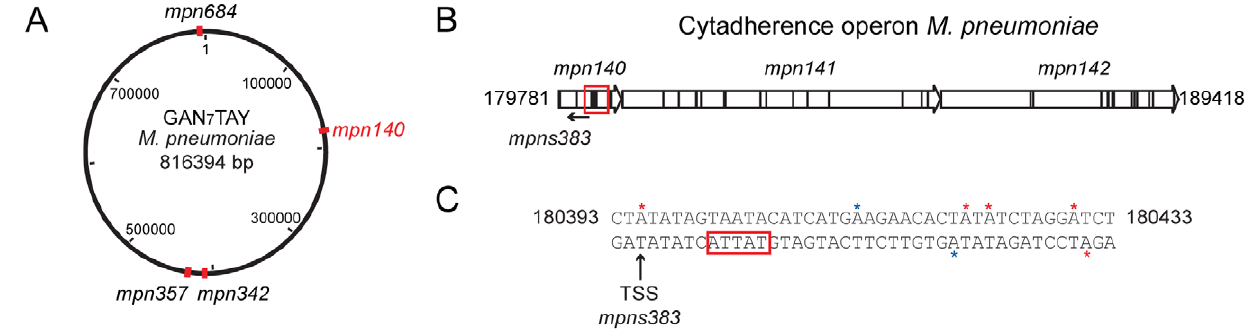
Figure 3. Genome-wide distribution of 5 9 -G A N 7 TAY-3 9 /3 9 -CTN 7 A TR-5 9 motif. ( A ) Map of the genome of M. pneumoniae representing the enriched regions for the 5 9 -G A N 7 TAY-3 9 /3 9 -CTN 7 A TR-5 9 motif. ( B ) Schematic representation of the cytadherence operon. The red square indicates the main ‘‘hot spot’’ of methylation for the Type I motif. ( C ) Upstream sequence of MPNs383. Red stars indicate the methylation by M.MpnI and blue stars indicate methylation by M.MpnII. The black arrow shows the transcriptional start site (TSS) of the MPNs383 and the red box the promoter sequence of this antisense RNA.